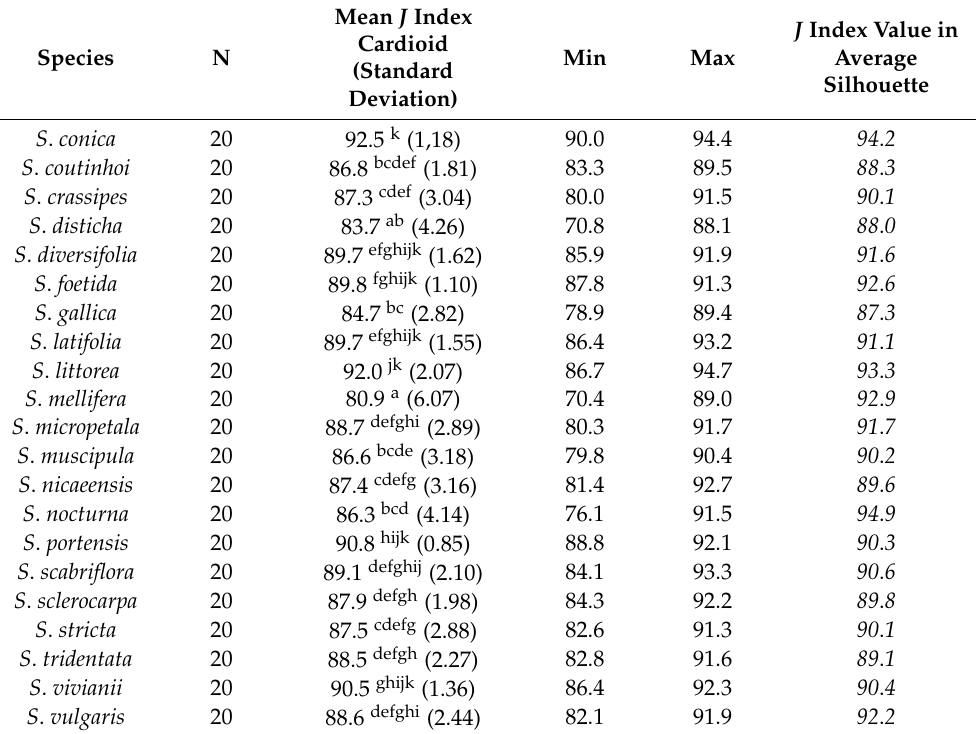
Table 6. J index values obtained in the comparison of the seed images and average silhouette with the cardioid (Model 1). The mean values and standard deviation (between brackets) are shown in the third column. The fourth and fifth columns show minimum and maximum values. The sixth column presents data obtained with the average silhouette for each species (values in cursive). Superscript letters indicate the results of Scheff é test: the mean values marked with a different letter in each column differ significantly at p < 0.05. N is the total number of studied seeds per species.